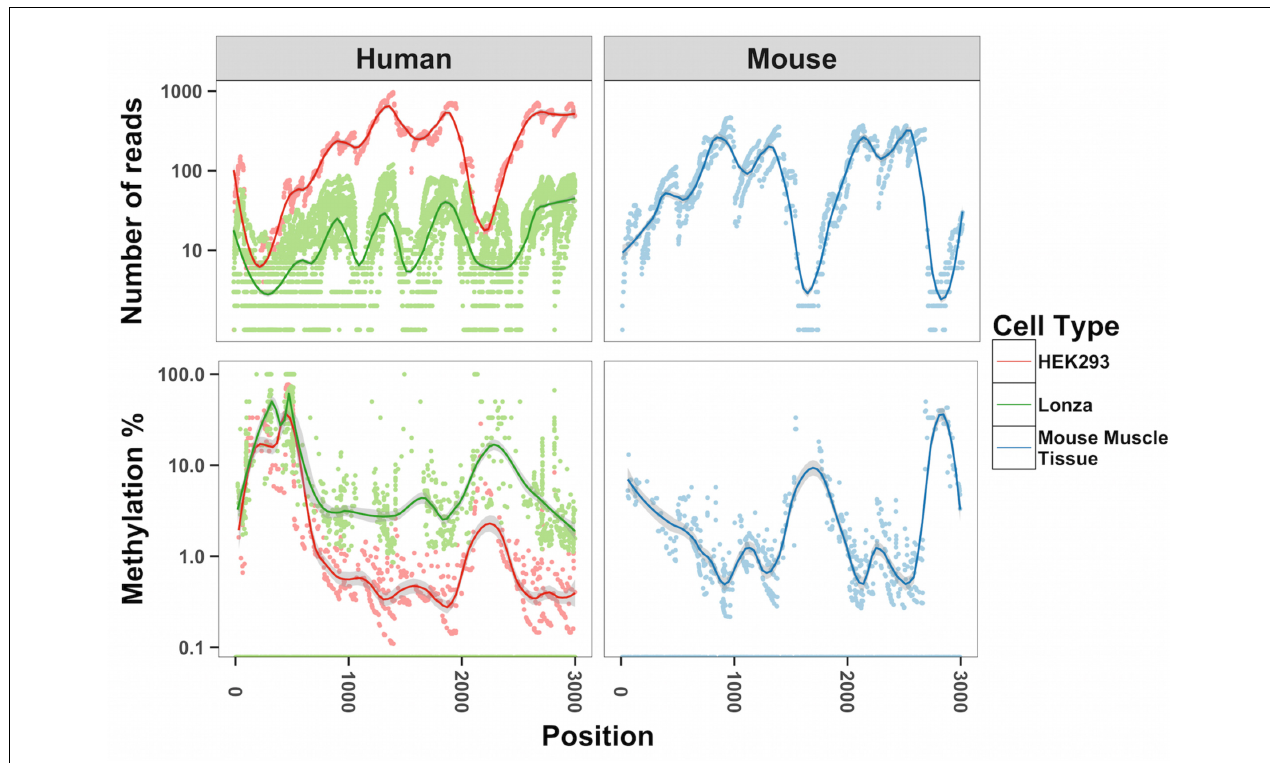
FIGURE 1 | Inverse relationship between methylation of mtDNA and sequencing depth. The number of reads and methylation percentage is shown in the mitochondrial genome from position 1000–3000 on the sense strand. In red, human HEK293 cells; in green, human primary muscle cells; in blue, mouse skeletal muscle. We analyzed all cytosines in each of the samples corresponding to 6,000–12,000